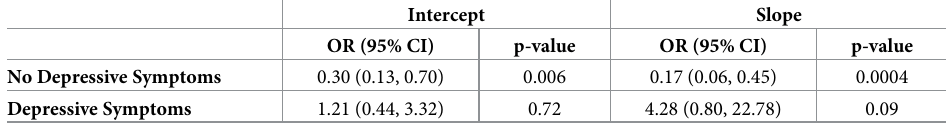
Table 4. Simple intercepts and slopes, proportion of days alcohol abstinent by depressive symptoms.